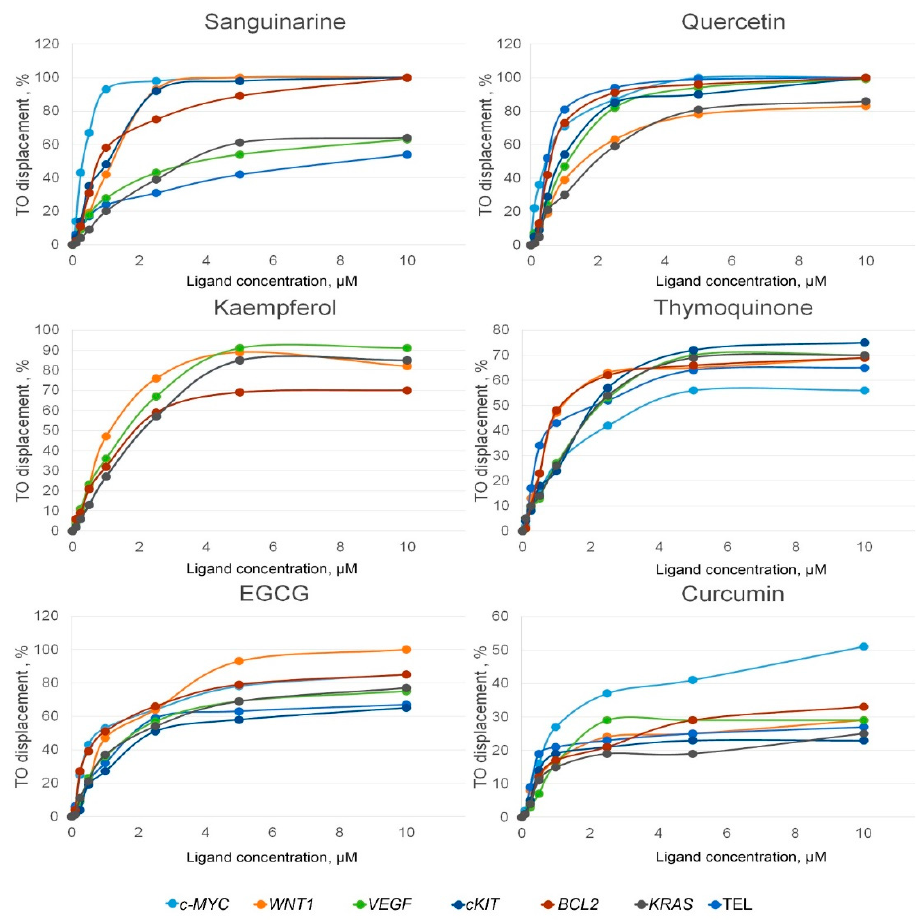
Figure 1. TO displacement from G4s formed by synthetic DNA oligonucleotides mimicking G-rich promoter regions of various oncogenes, depending on the concentration of added PSMs.